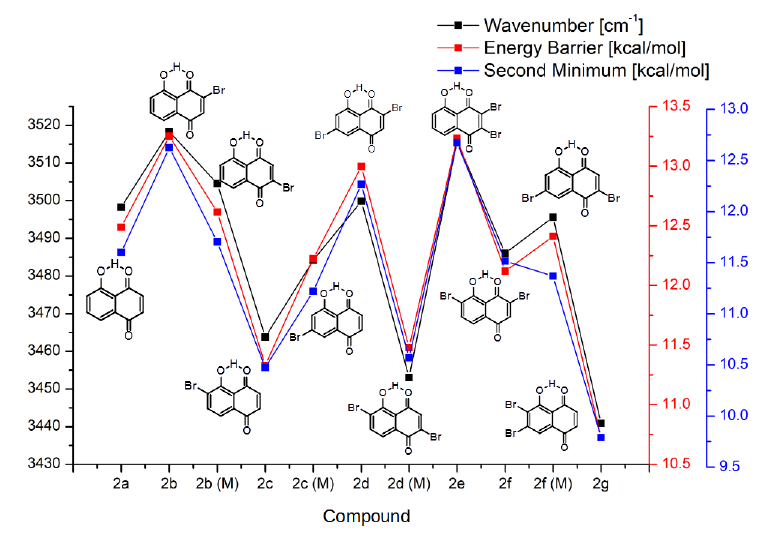
Figure 5. The ν OH stretching wavenumber, energy barrier and the second minimum energy values in group 2 of the studied compounds.